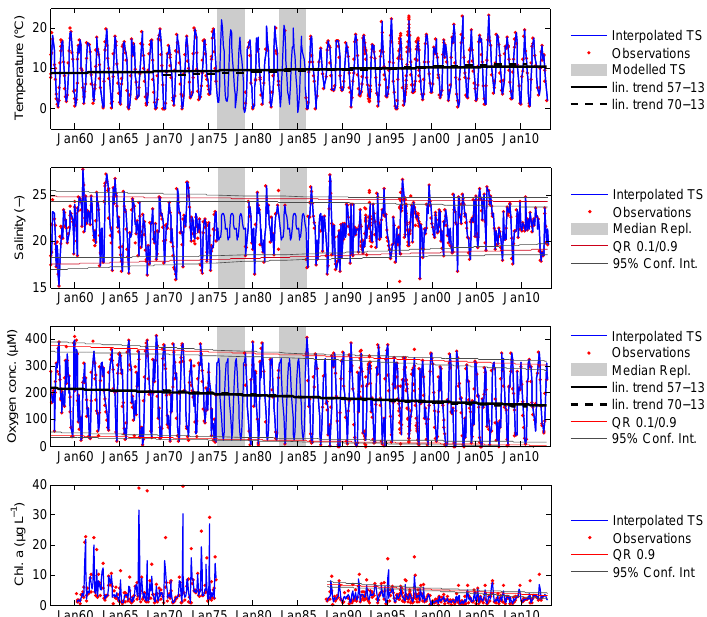
Figure 4. Time series of temperature (1m), salinity (25m), oxygen (25m) and chlorophyll a concentration (10m). Shown are various statistical results discussed in Sect. 3, e.g. quantile regression (QR) or linear trends over different time spans. TS: time series; Median Repl.: median replacement; Conf. Int.: confidence interval of quantile regression; Chl. a : chlorophyll a .